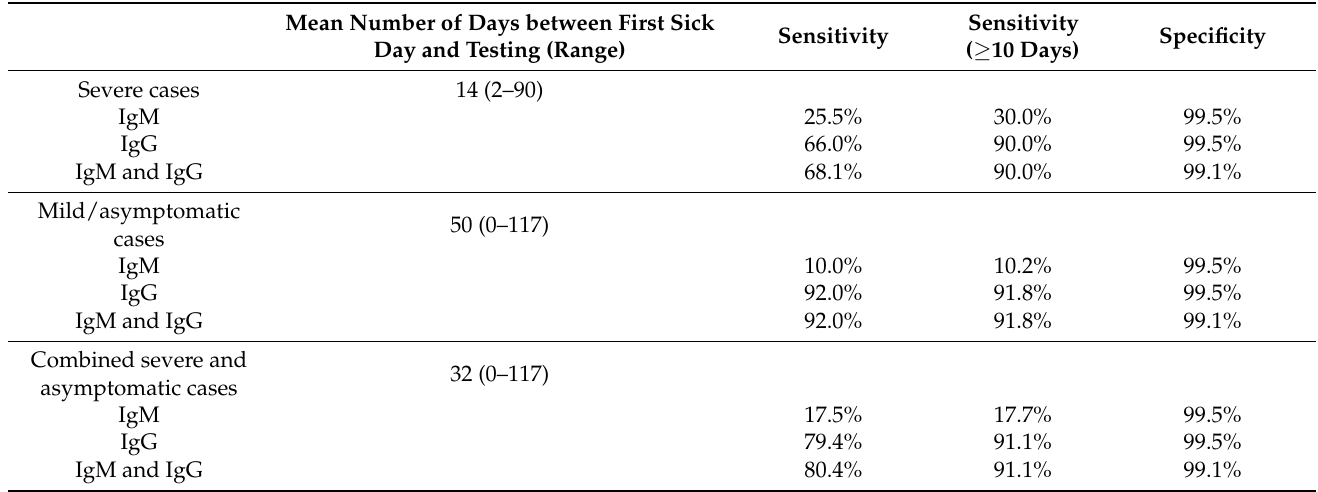
Table 2. Sensitivity and specificity of the Biozek COVID-19